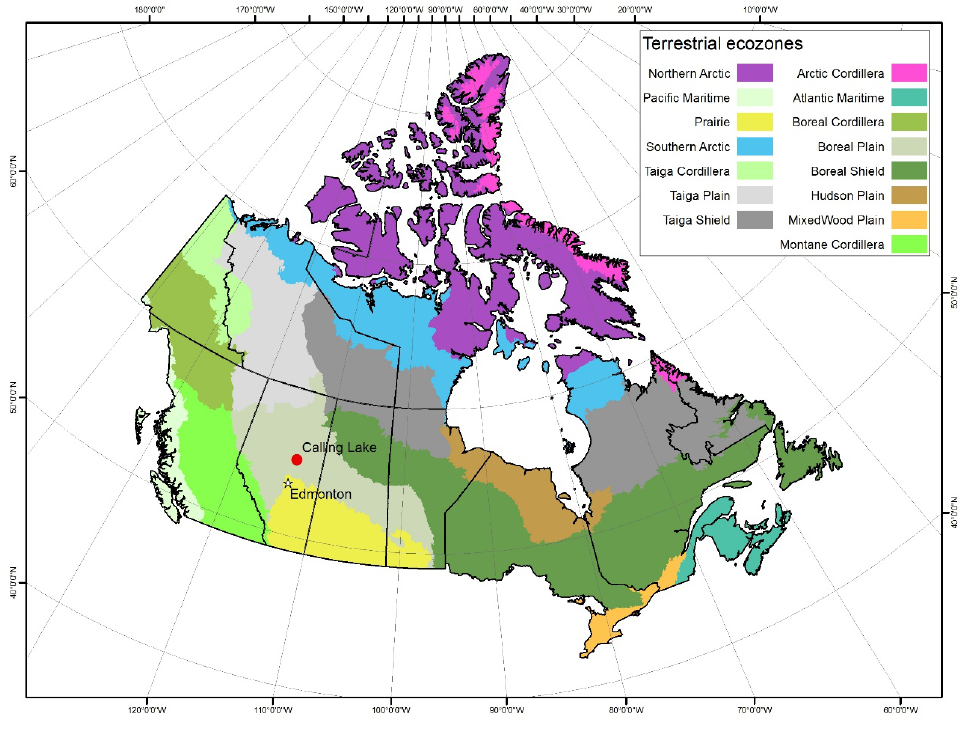
Figure 1. Study site location in Canada. Table 1. Description of the five blocks used for the study, based on preharvest assessment information for the blocks.